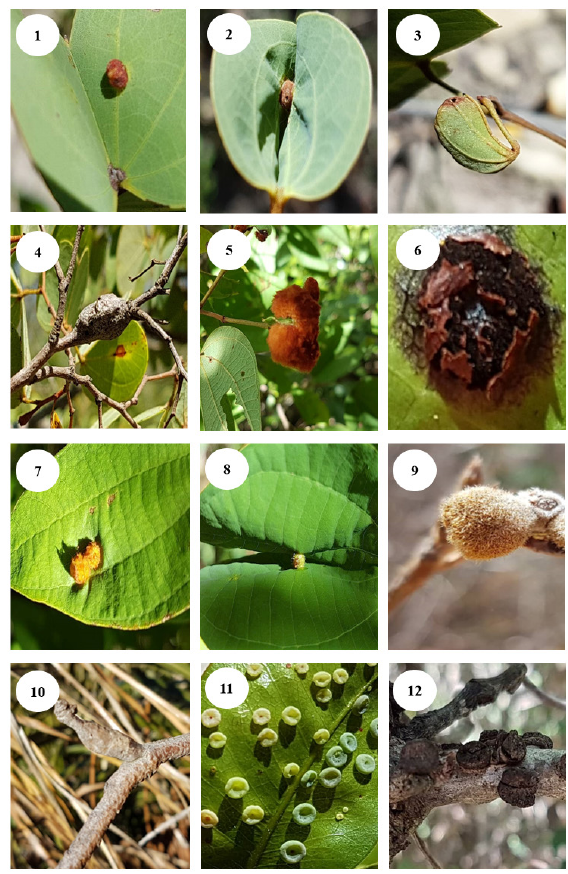
Figure 1. Insect galls associated on Fabaceae occurring in Brazil. 1-4, Bauhinia pulchella B enth., 5-6, Bauhinia sp., 7-8, Bauhinia acuruana Moric., 9-10, Calliandra macrocalyx Hamrs, 11-12, C opaifera langsdorffii Desf. Images: Tainar